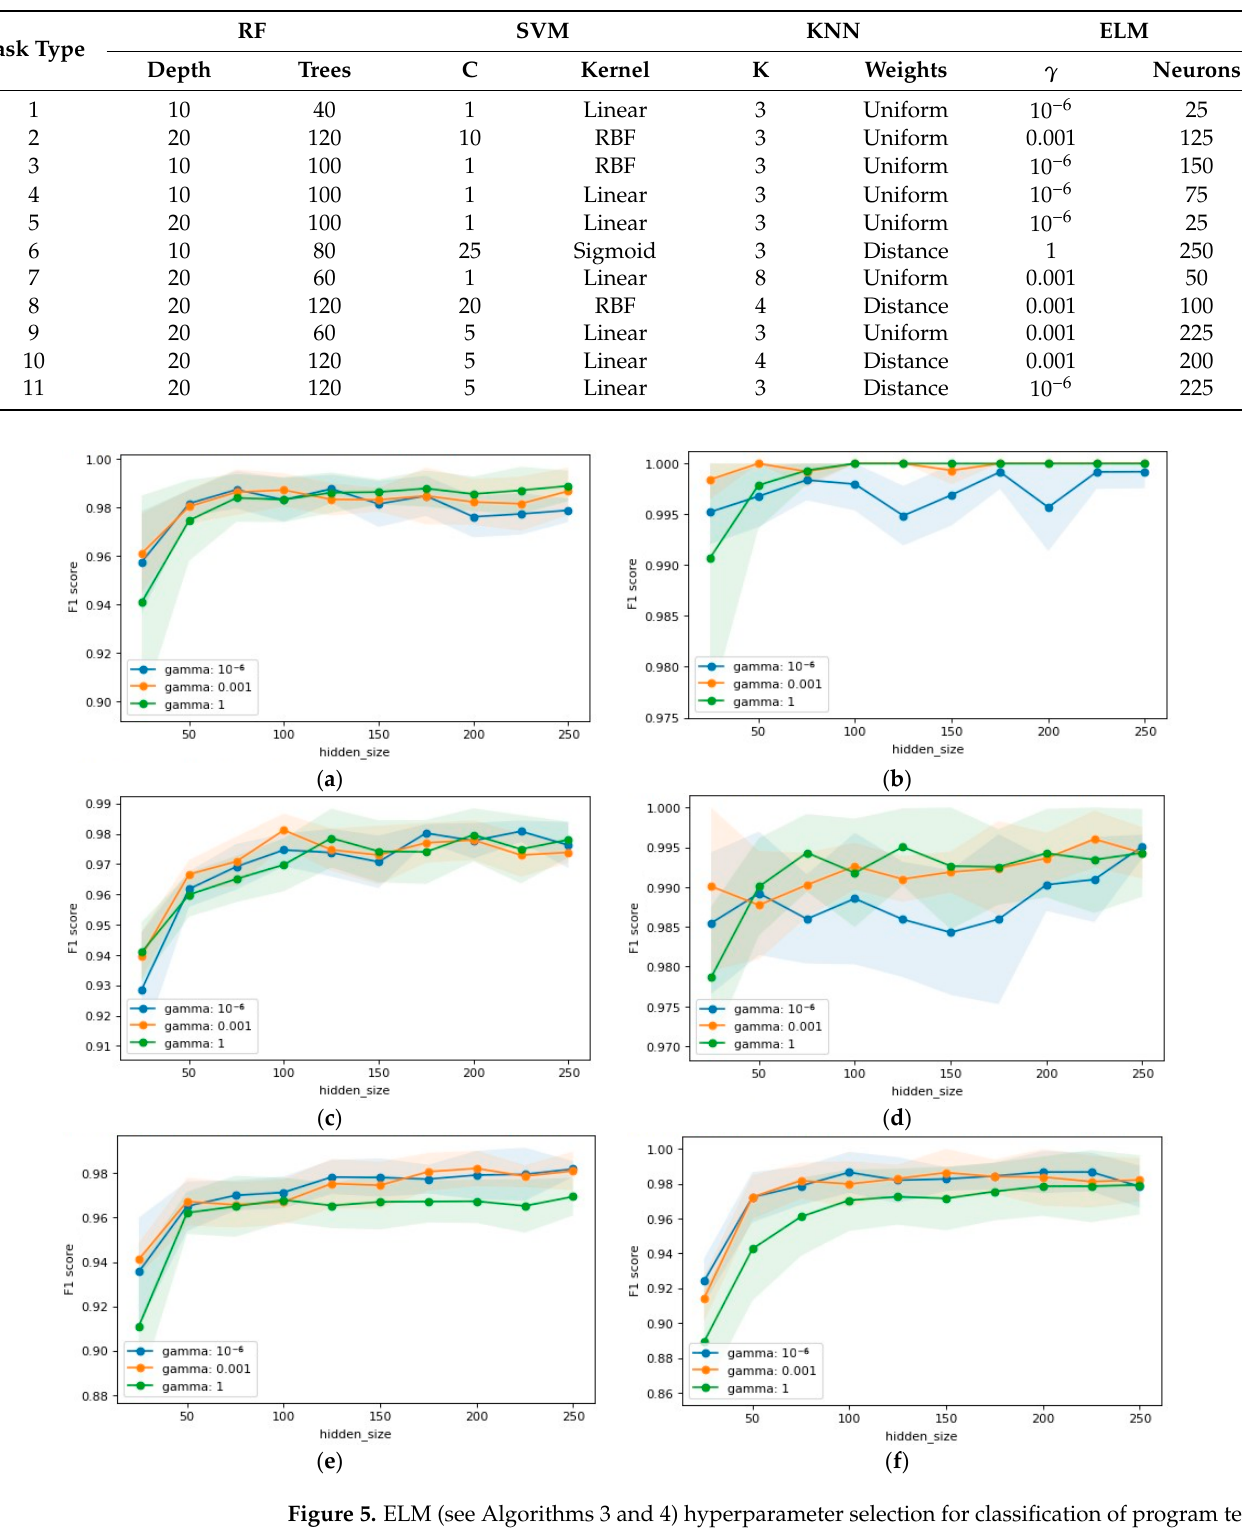
Table 4. Parameters selected for SVM, RF, KNN, and ELM using grid search maximizing (10).